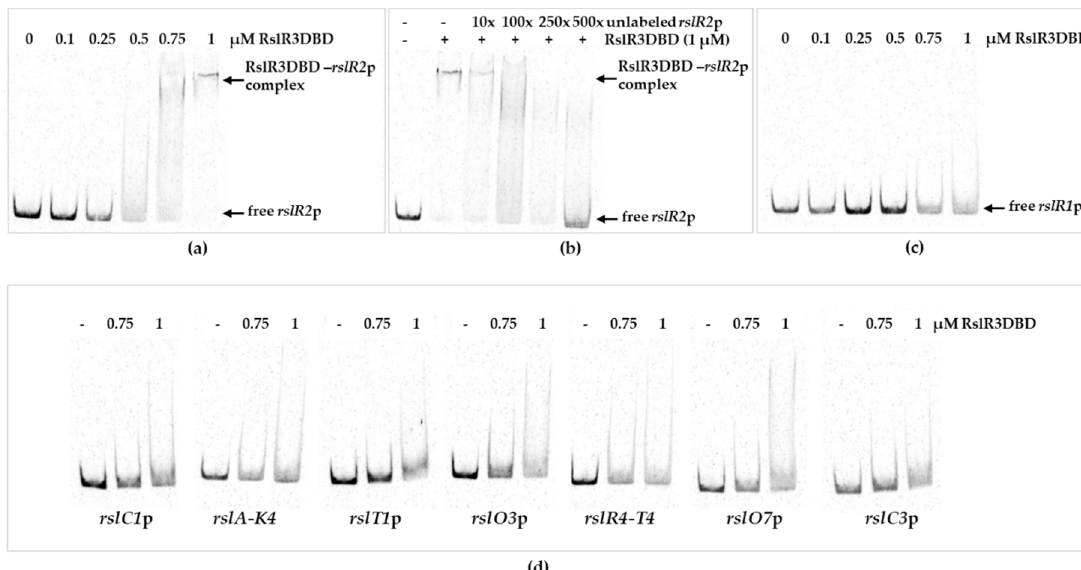
Figure 4. Electrophoretic mobility shift assay to study binding of RslR3DBD to promoter region of rslR1 , rslR2 , and structural genes. ( a ) EMSA containing rslR2 p; ( b ) competition assay of RslR3DBD (1 µ M) with rslR2 p carrying 10, 100, 250, and 500-fold excess of unlabeled probe; ( c ) EMSA containing rslR1 p; ( d ) EMSA containing promoters of structural genes.